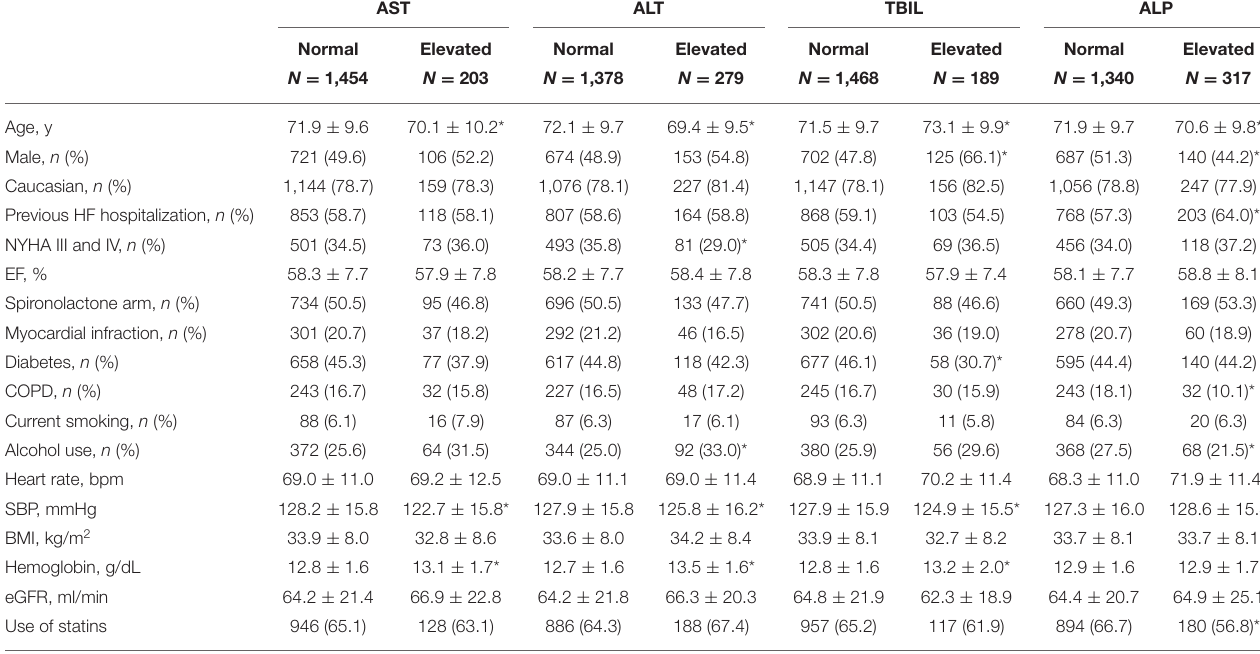
TABLE 1 | Baseline characteristics of patients with and without abnormal liver function tests. AST ALT TBIL ALP Normal Elevated Normal Elevated Normal Elevated Normal Elevated N = 1,454 N = 203 N = 1,378